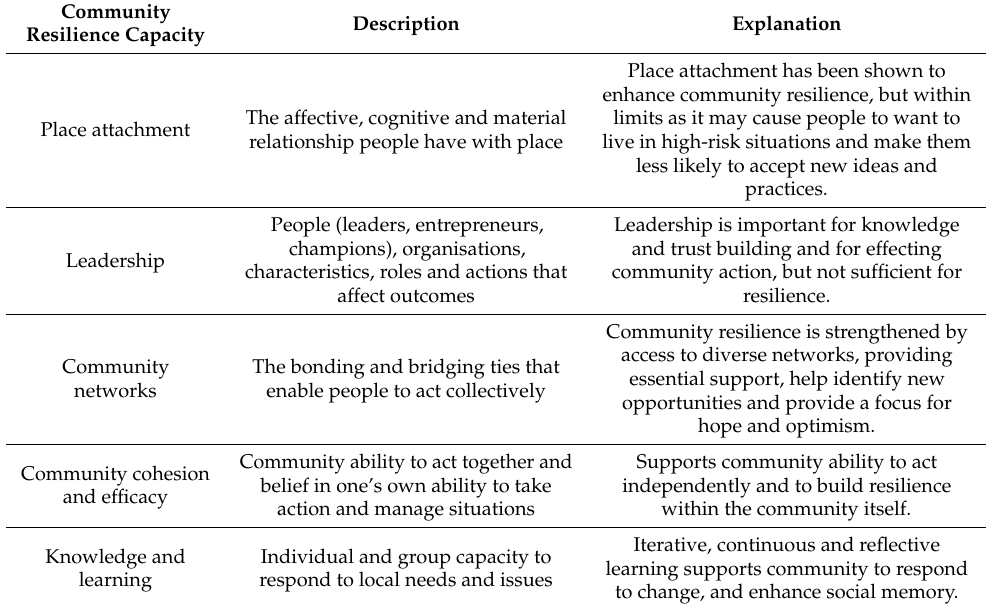
Table 1. Capacities supporting community